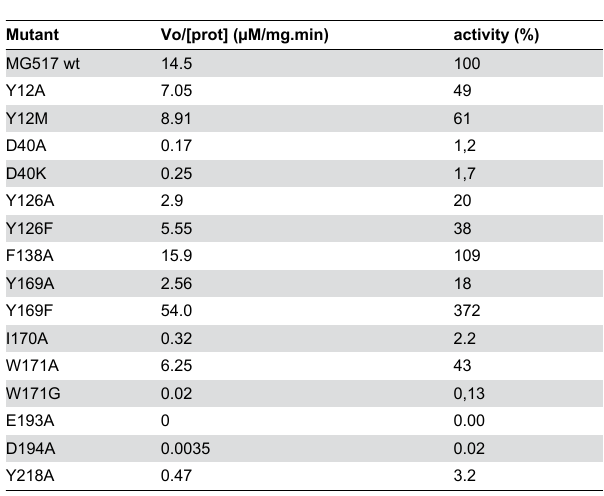
Table 2. Enzymatic activity of GT MG517 mutants.